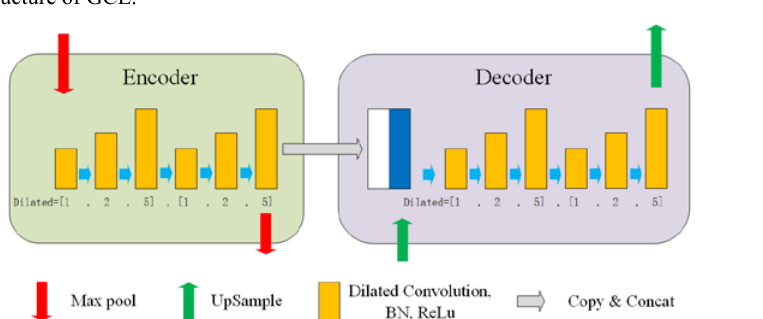
Fig. 2. Structure of GCE.